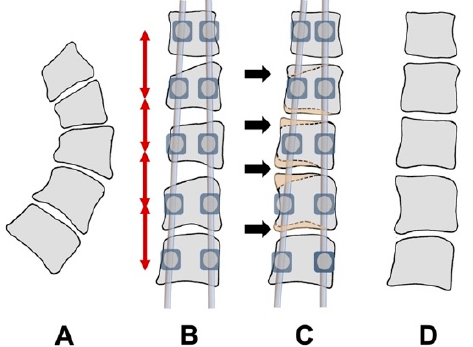
Figure 11. Illustration showing the growth modulation induced by the correction of scoliosis, and posterior stabilization using pedicle screws and rods. ( A ) original curve; ( B ) correction of the major curve with standard techniques using pedicle screws and rods (see red arrows showing distraction forces applied to the intervertebral spaces on the concave side); vertebral wedging was initially maintained at the apical segments; ( C ) the restoration of the apical vertebral shape was achieved by the growth of the epiphyseal plate on the concave side (see arrows) due to distraction of the intervertebral space, while the growth of the convex side was blocked by the lack of distraction made by the pedicle screws on that side; ( D ) the final result after the removal of the instrumentation, showing an almost normal vertebral shape. In the figure, the placement of the transverse hooks at the proximal upper vertebra was not included, because this was not essential for the growth-modulation technique.